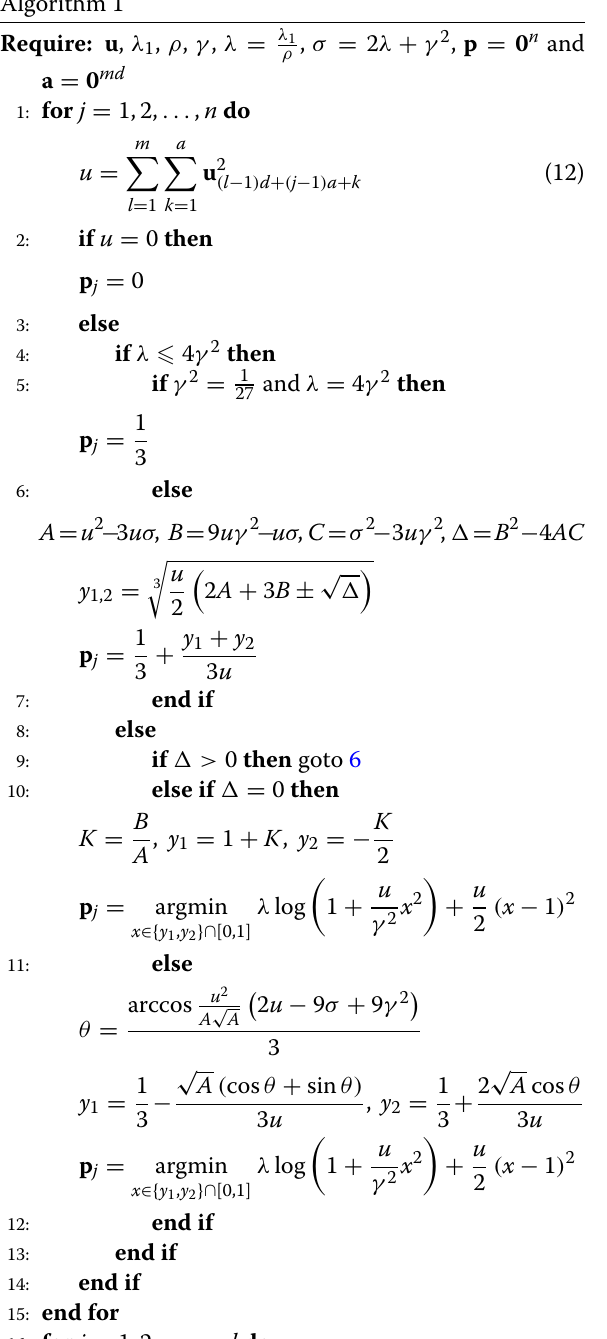
Algorithm 2 (cid:7) : Inner Update Algorithm of a in Algorithm 1